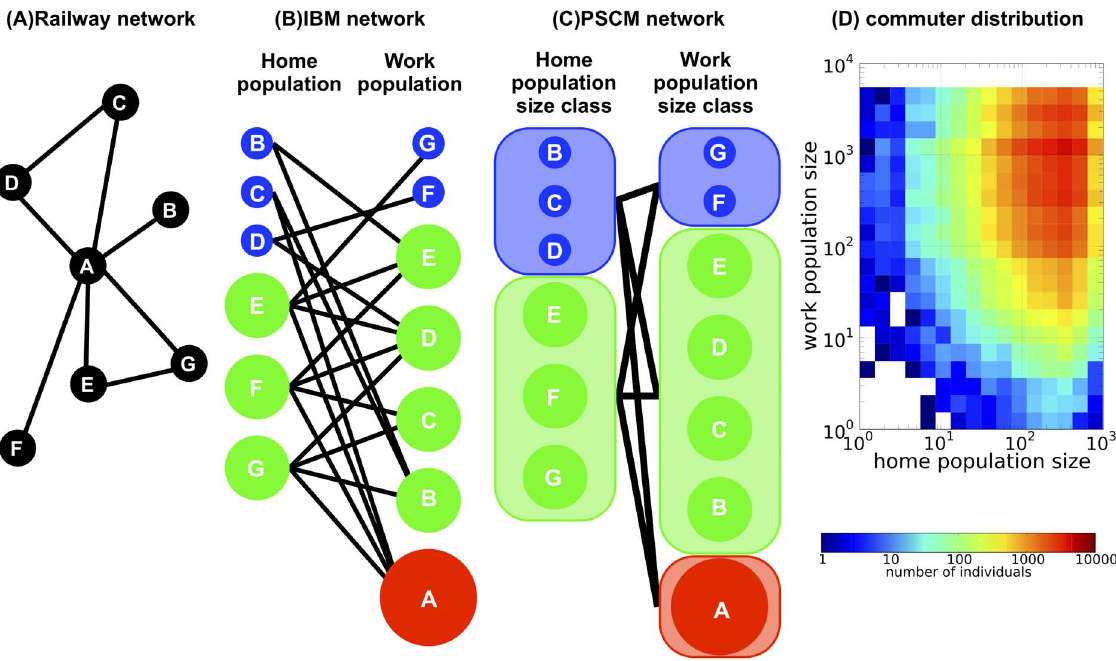
Figure 2. Schematic representation of the population size class model (PSCM). (A) Geographical distribution of the railway network; each node corresponds to a station and each line corresponds to a commuter railway of commuter trains. Every station has a home population (those who reside in the area) and a work population (those who travel to as a workplace/school in the area). There are multiple commuters using the commuter train between each pair of populations. (B) The commuter network utilized in the individual-based model (IBM) calculations. The nodes correspond to the home and work populations of each station, forming a bipartite network in which each line denotes a connection via commuter flow between home and work populations. Local populations with different population sizes are represented by different colors and sizes. (C) The commuter network utilized in the PSCM calculation. Local populations with similar population sizes are grouped into population size classes, which form the nodes, while the total commuter flows between pairs of population size classes form the lines. (D) Joint distribution of the home and work population sizes of commuters in the Tokyo metropolitan area. The number L nm of commuters that live in a home population of size class n and commute to a work population of size class m is plotted as a density plot. The data were obtained from the Urban Transportation Census (UTC) commute data (Ministry of Land, Infrastructure, Transport and Tourism, The 10th Urban Transportation Census Report, 2007; in Japanese).